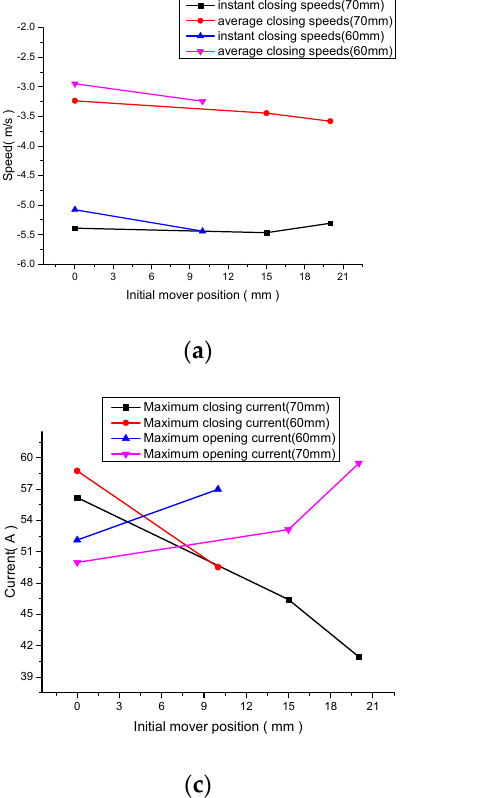
Figure 9. The opening and closing characteristics are shown when the length of the mover are 60 mm and 70 mm. ( a ) The characteristic of the initial mover position vs. closing speed. ( b ) The characteristic of the initial mover position vs. opening speed. ( c ) The characteristic of the initial mover position vs. maximum current.